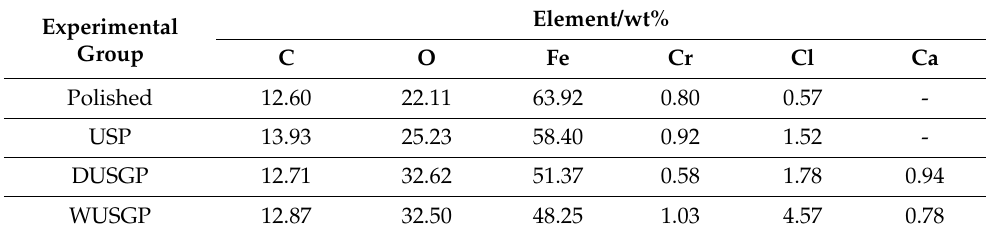
Table 4. Element atomic fraction of corrosion product in crack area of samples.